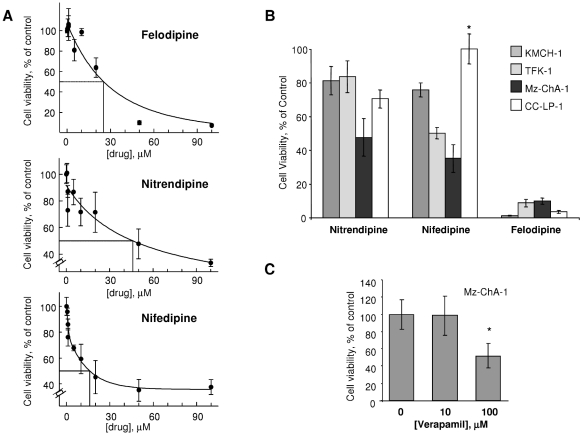
Cytotoxicity of candidate agents to cholangiocarcinoma cells.Panel A: Mz-ChA-1 cells were seeded into 96-well plates at a cell density of 5,000 cells per well in media with 5% FBS at 37°C with 5% CO2. After incubation overnight felodipine, nitrendipine, or nifedipine were added at the concentrations indicated, and cell viability assessed after 72 hours using a metabolic assay (CellTiter 96 AQ, Promega Corp., Madison, WI). Cytotoxicity as a percent of control is plotted against the concentration for each. The data represents the mean and standard deviation of five separate determinations. All three compounds decreased cell viability in a concentration-dependent manner, with an IC50 for felodipine of 26±5 µM, nitrendipine, 44±10 µM and nifedipine, 15±4 µM. Panel B: KMCH-1, CCLP-1, Mz-ChA-1 and TFK-1 cholangiocarcinoma cells were incubated with the candidate agents at a concentration of 50 µM. Cell viability was assessed after 72 hrs using a viable cell assay. A significant reduction in cell viability was observed with each agent and in each cell type, except as indicated (N:5* p>0.05 relative to controls). Panel C: Mz-ChA-1 cells were incubated with verapamil at the indicated concentrations or diluent control and cell viability assessed after 72 hours using a metabolic cell viability assay (N:7 * p<0.05 relative to control).